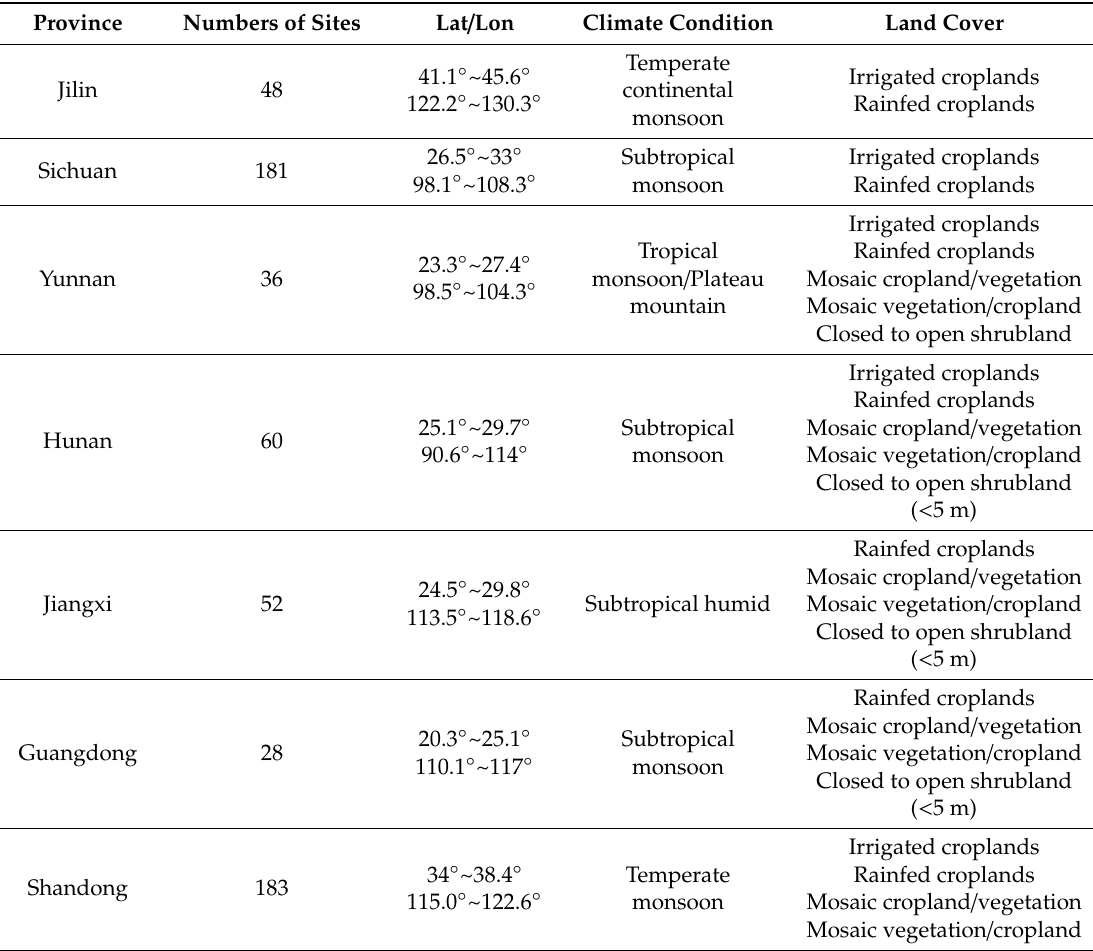
Table 3. Characteristics of the in situ